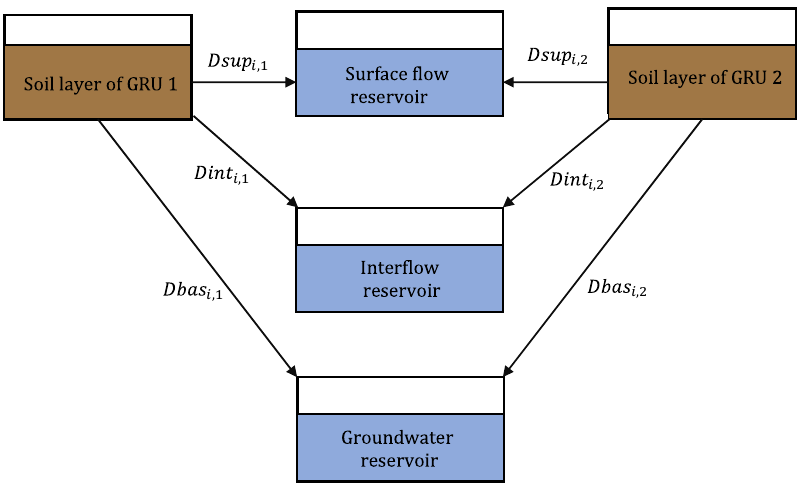
Figure 6. Schematic diagram of linear reservoirs used by the MGB-IPH model. Adapted from: